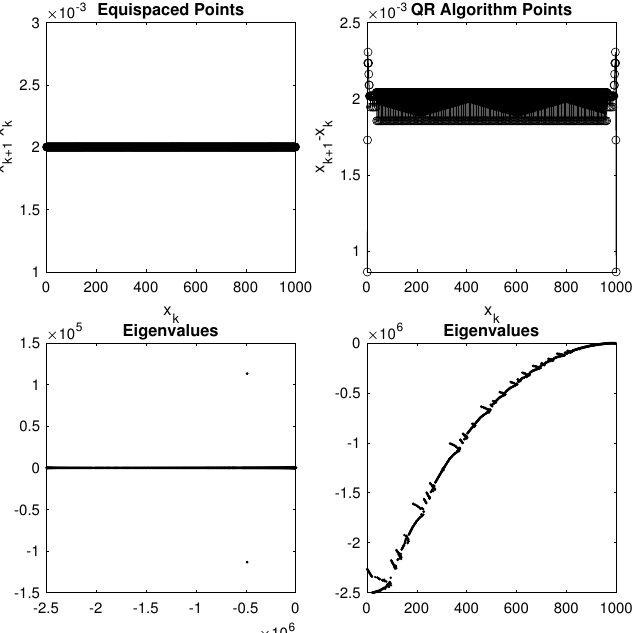
Figure 8. MCpQR algorithm point spacing and Dirichlet Laplacian eigenvalues compared to equis- paced